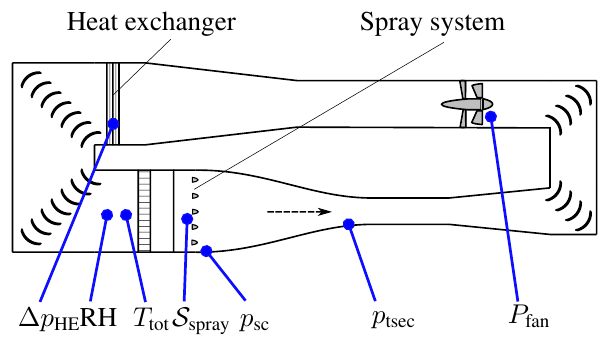
Figure 12. Basic instrumentation of the Braunschweig Icing Wind